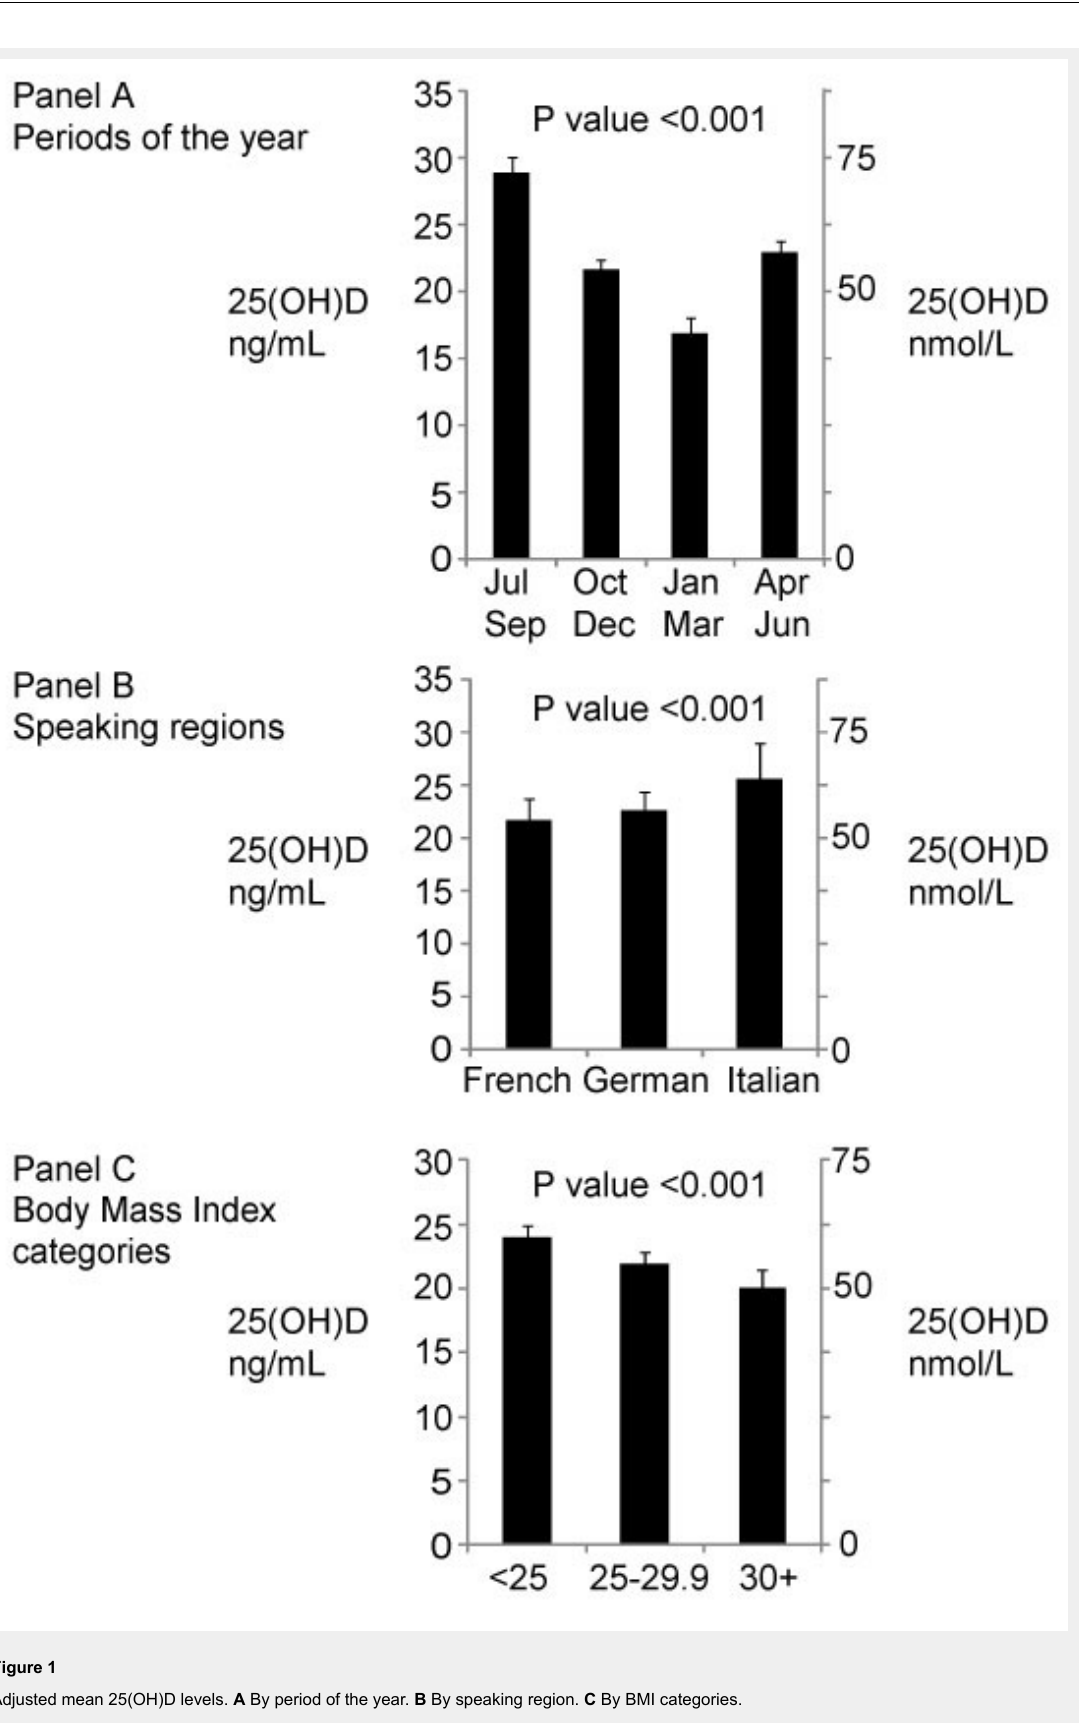
Figure 1 Adjusted mean 25(OH)D levels. A By period of the year. B By speaking region. C By BMI